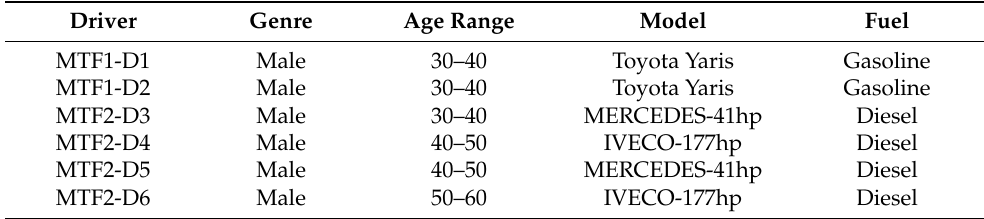
Table 3. Drivers and vehicles in the MOTIF-1 and MOTIF-2